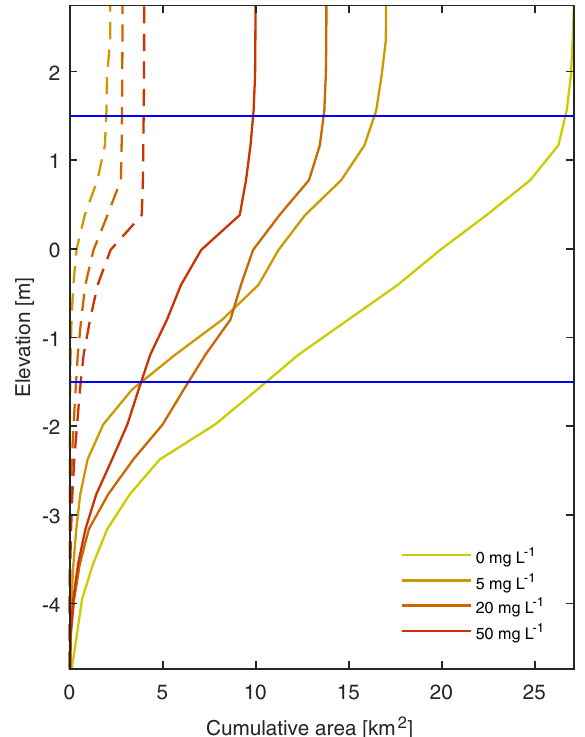
Figure 7. Hypsometric curves of the final bathymetry after 2000 years. Curves indicate the cumulative area below a certain eleva- tion. Dotted lines indicate the mud-covered area below this eleva- tion. Runs 03, 10, 01 and 09 with 0, 5, 20 and 50mgL − 1 fluvial mud supply